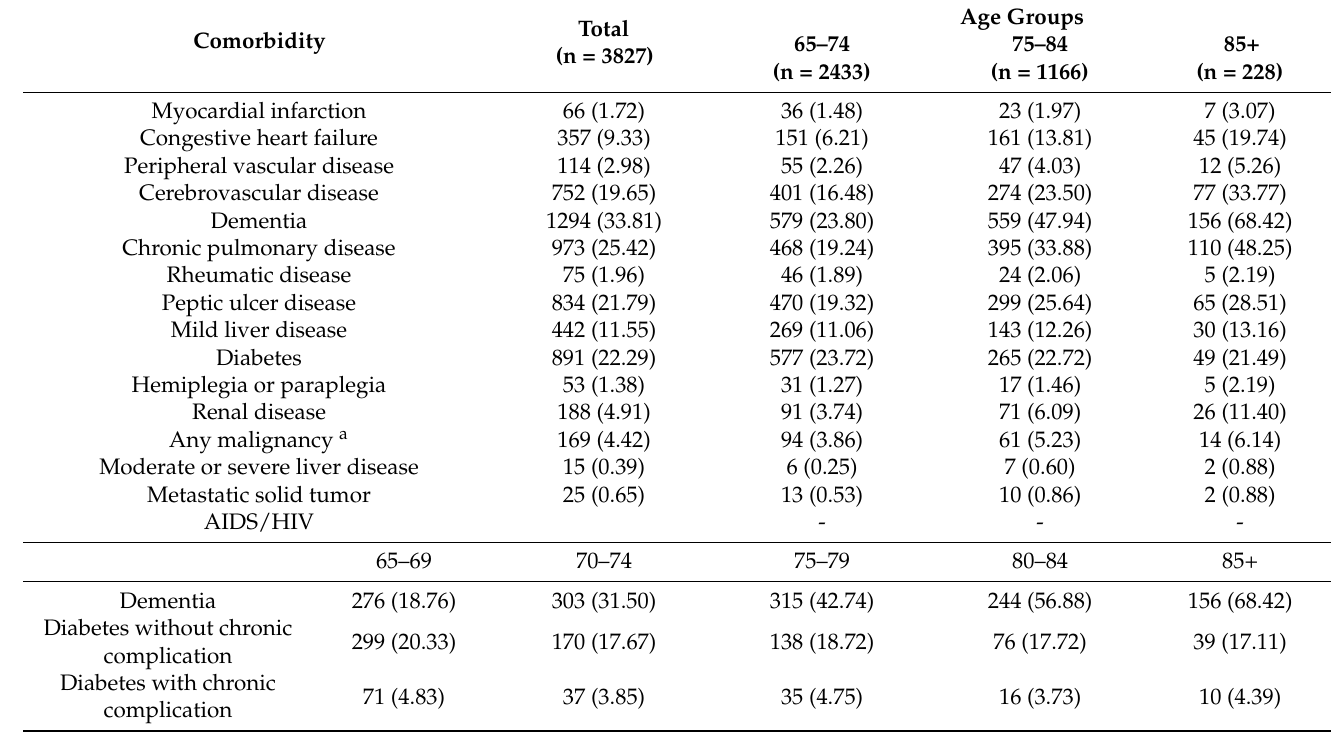
Table 3. Comparison of frequency of comorbidities in different age groups of patients with